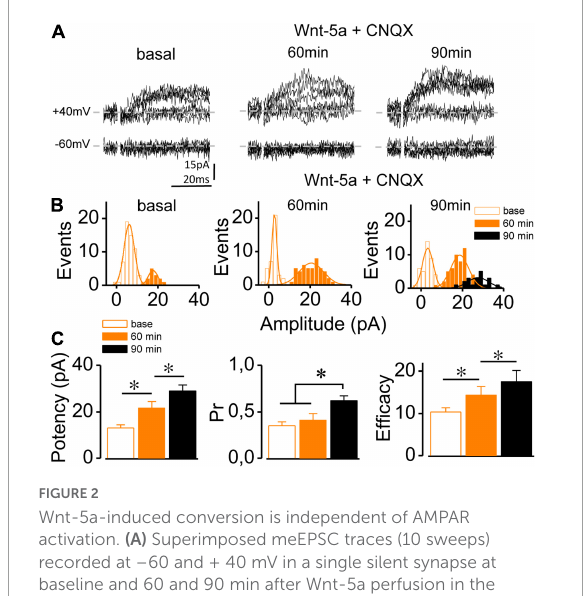
FIGURE2 Wnt-5a-induced conversion is independent of AMPAR activation. (A) Superimposed meEPSC traces (10 sweeps) recorded at –60 and + 40 mV in a single silent synapse at baseline and 60 and 90 min after Wnt-5a perfusion in the presence of CNQX (20 µ M). (B) Representative cumulative histogram of meEPSC amplitude at + 60 mV before (basal) and after 60 and 90 min of Wnt-5a plus CNQX treatment showing failures (white bars) and successes (orange-black bars). (C) The average change in the synaptic potency, Pr, and synaptic efficacy at baseline and after 60 and 90 min of Wnt-5a plus CNQX, measured at + 40 mV. Statistics: Error bars indicate ± SEM, t -test (* p <